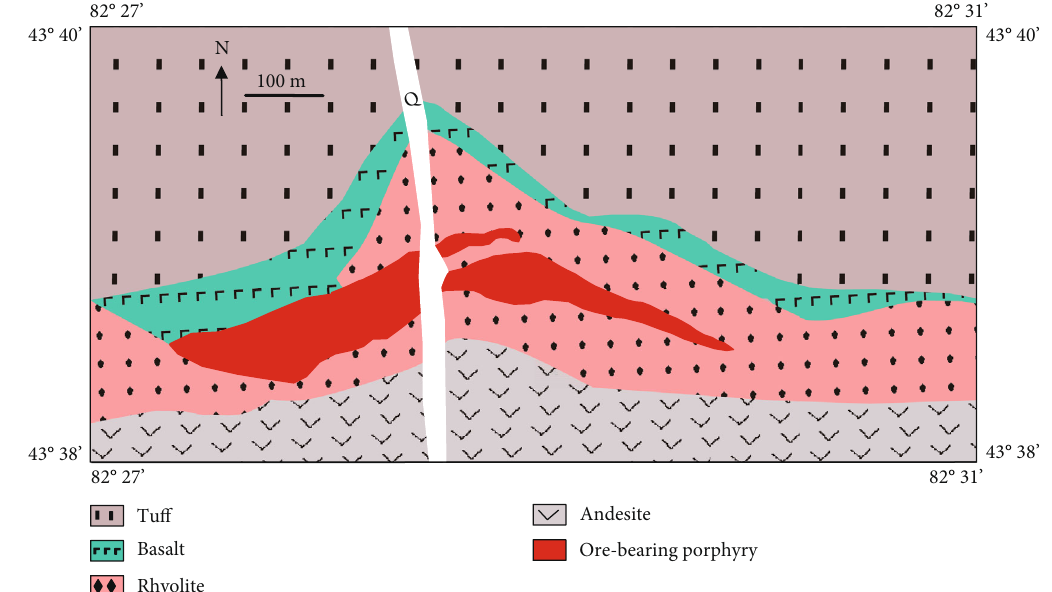
Figure 2: Sketch map of the 109 porphyry Cu deposit (modi fi ed from Zhao et al.